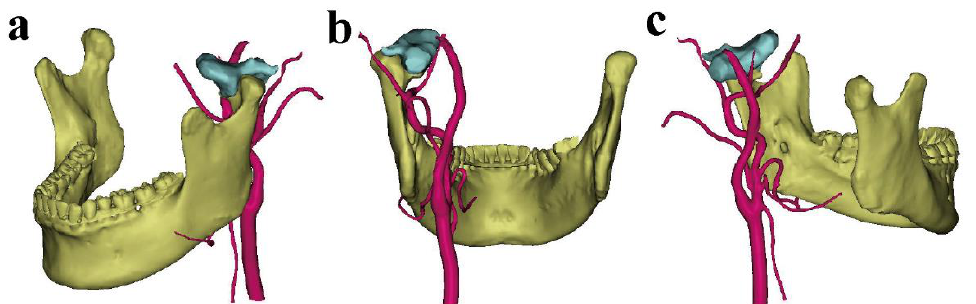
Figure 1. The different views of 3D reconstruction of the mandible, condylar OC, and vascular bun- dle: ( a ) mean lateral view; ( b ) mean posterior view; ( c ) mean medial view. (The mandible is shown in yellow, the condylar OC in light blue, and the vascular bundle in red.)